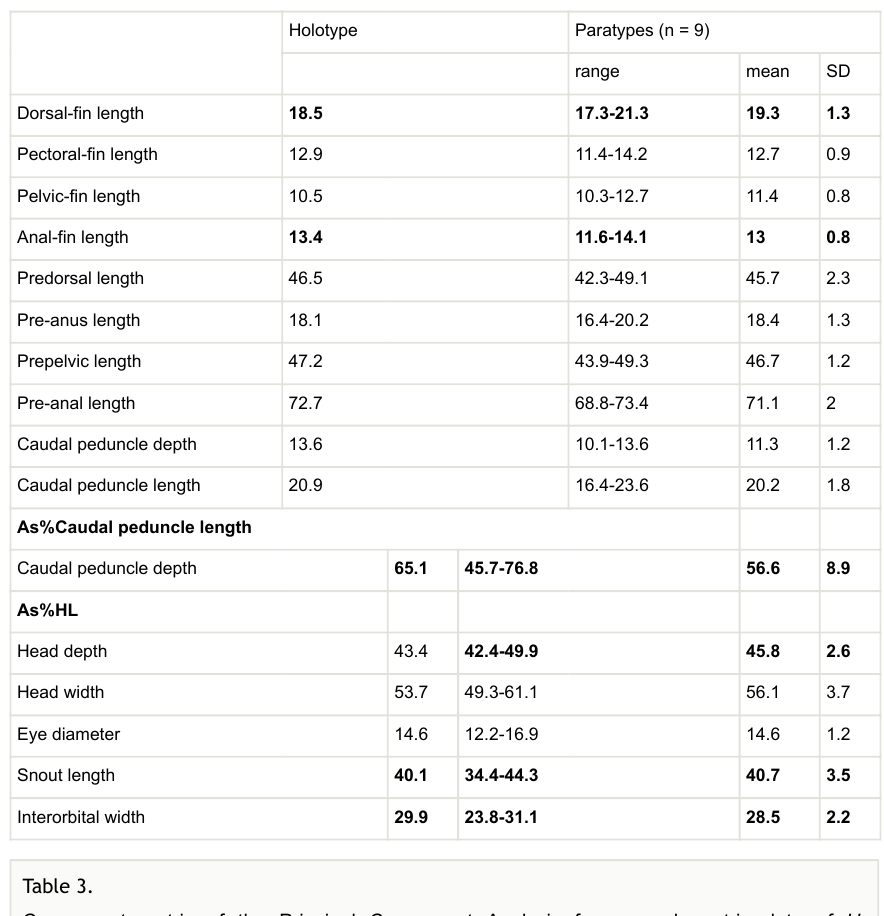
Component matrix of the Principal Component Analysis from morphometric data of H. guanheensis and H. laxiclathra